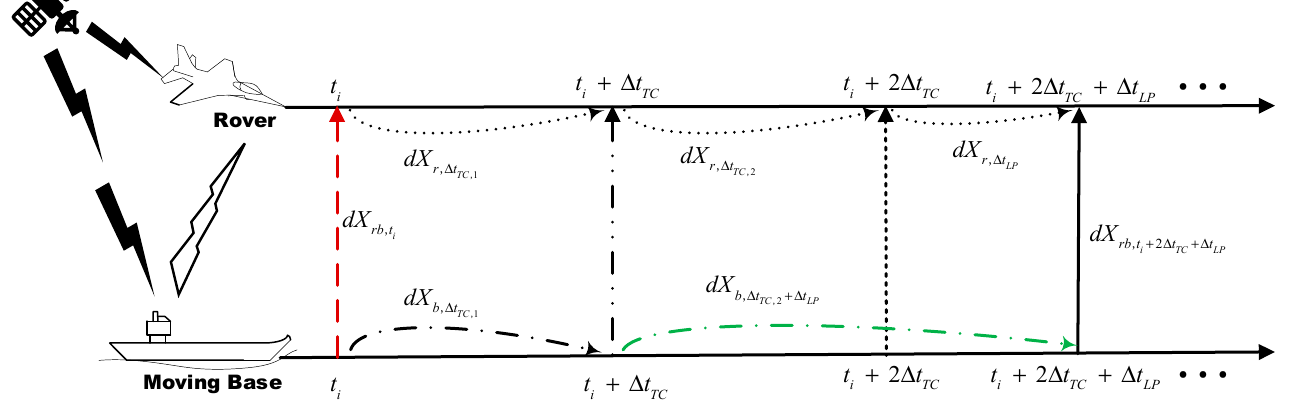
Figure 3. Integration mechanism of the position increment condition in the presence of latency. Figure 4 shows the integration mechanism of synchronous relative position in the presence of broadcast latency affecting the raw GNSS observations. N denotes the total number of position increments between adjacent RTK DGNSS relative positions; t denotes the broadcast latency; + denotes the time when the RTK DGNSS relative 1 i d X denotes the corresponding relative position, which position can be obtained; and + 1 , i rb t is represented by red dotted vertical arrows. The current observation time is t , where TC LG